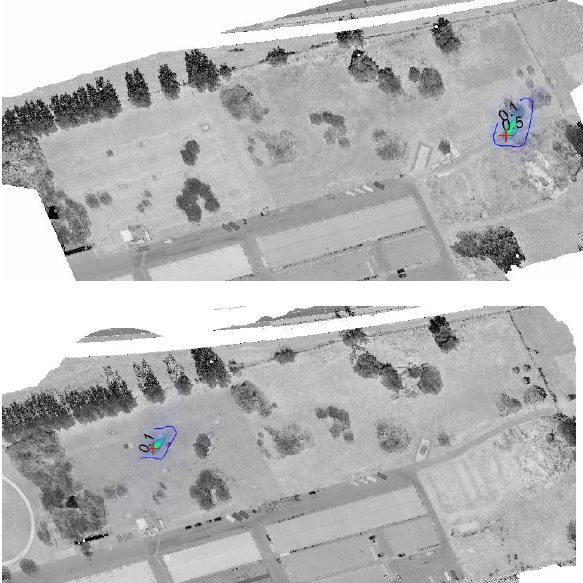
Figure 11. Result of source location processing, scenario A (top), scenario B (bottom).